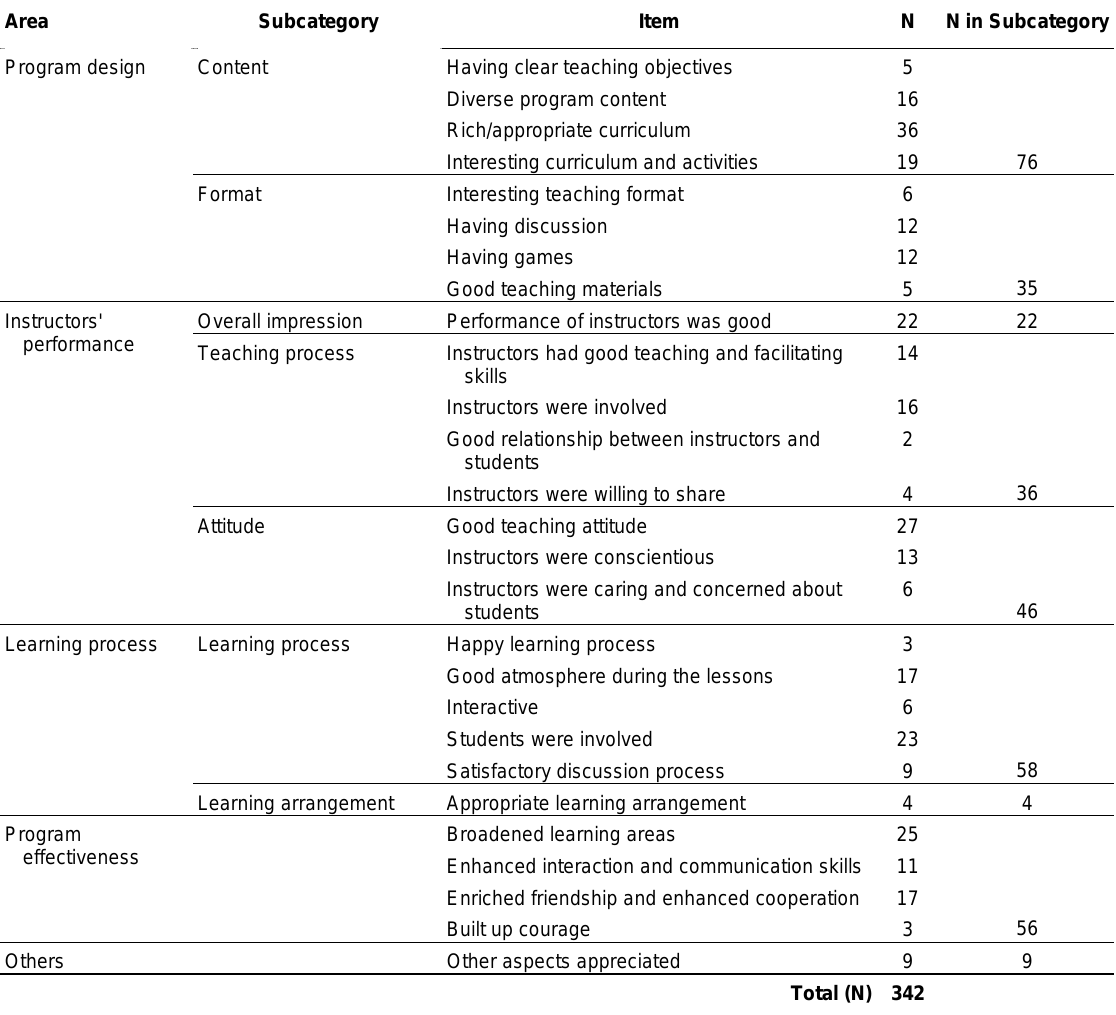
Summary of the Students' Responses to the Question “What were the Things the Students Appreciated most in the